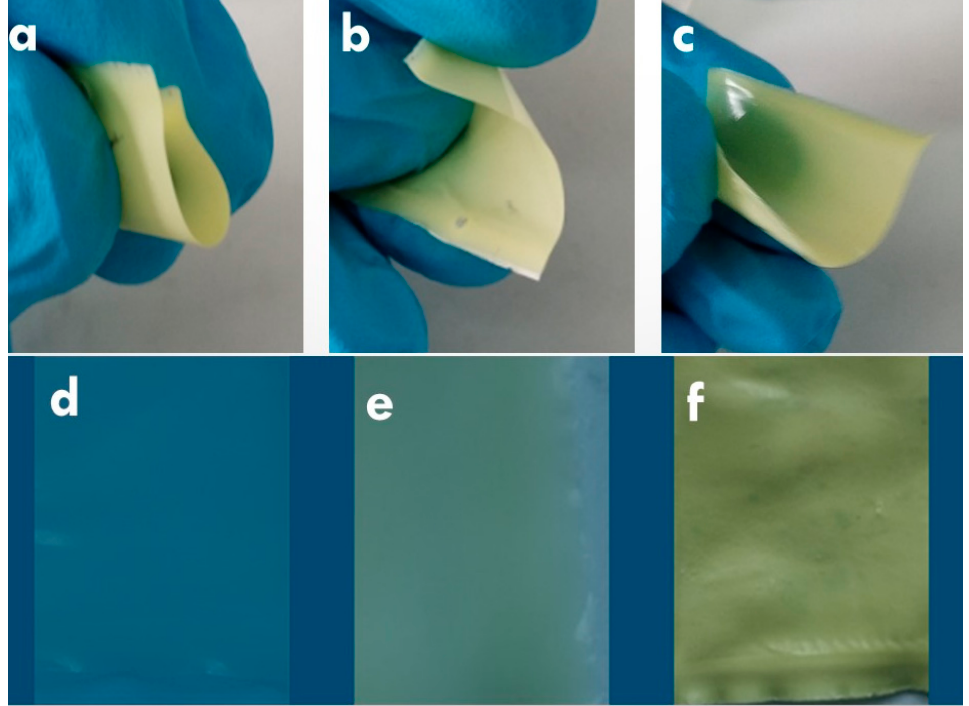
Figure 4. Flexibility of [Cu 2 I 2 (Apyz)] n @PLA-30% ( a , b , c ) and degree of visual transparency of the [Cu 2 I 2 (Apyz)] n @PLA-1% ( d ), [Cu 2 I 2 (Apyz)] n @PLA-4% ( e ) and [Cu 2 I 2 (Apyz)] n @PLA-30% ( f ).